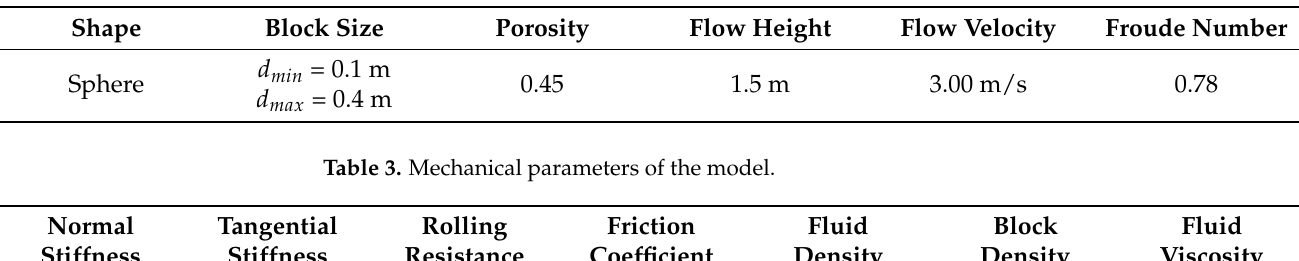
Table 2. Input parameters of the numerical model of reference case.